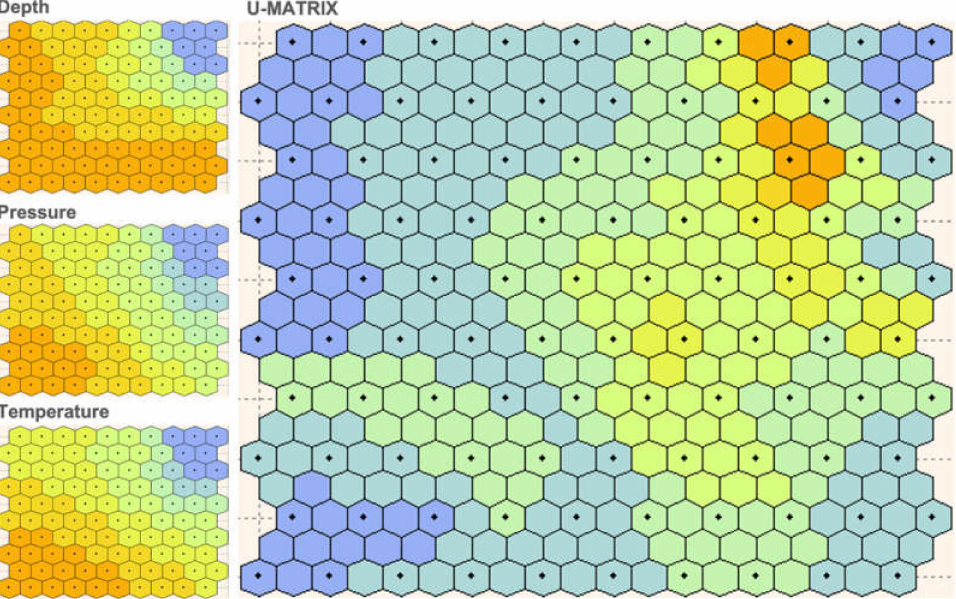
Figure 13. Input layers for depth, pressure and temperature, and the resulting U-matrix for all attributes for Basin Y . Cool colours indicate small distances between data points (clustering), warm colours represent large distances between data in multidimensional space.